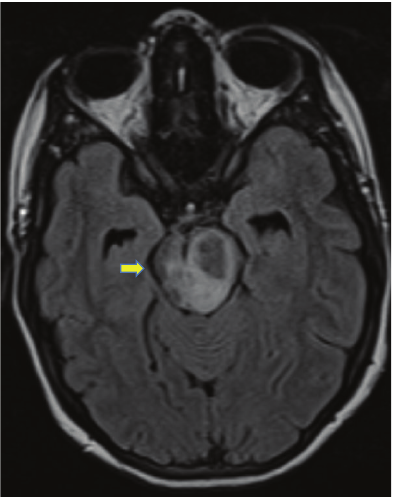
Figure 1: Tuberculoma in the left pedunculus cerebri at time of first encounter (frontal view).